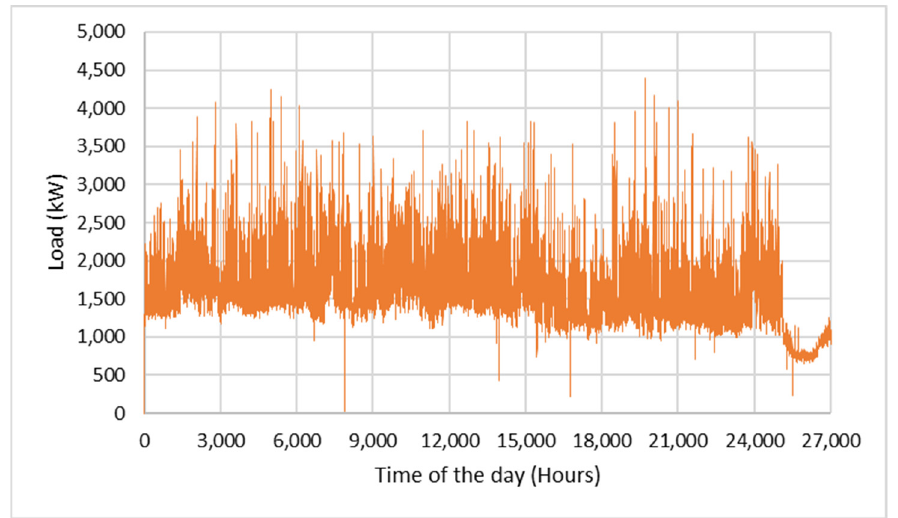
Figure 8. Total load time series for the years 2018–2020.